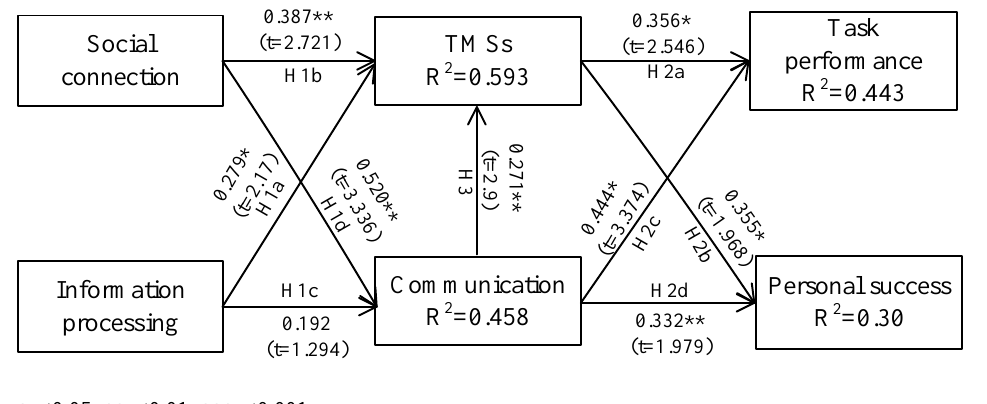
Figure 2. Results of PLS